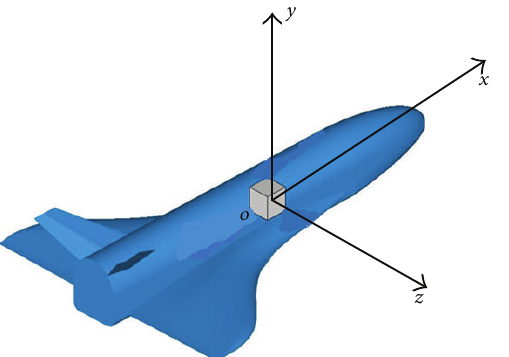
Figure 2: Body coordinate system of